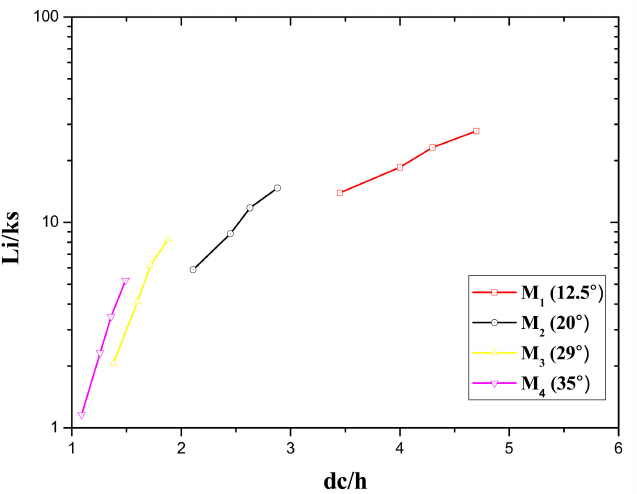
Figure 10. Normalized inception point (Li/ks) relationship with the relative critical depth of different sloped stepped